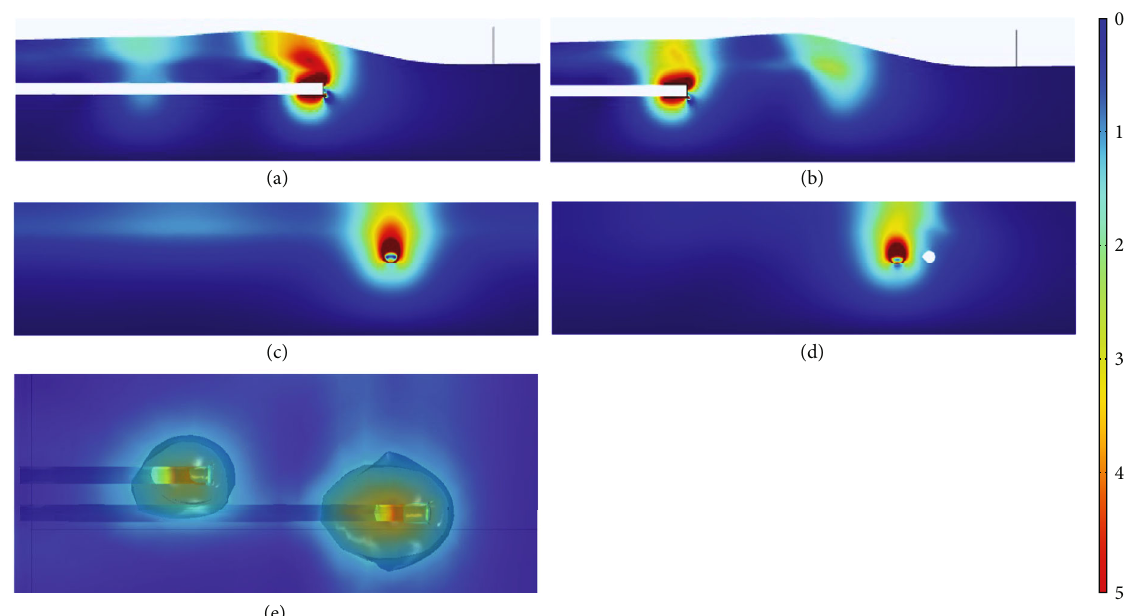
Figure 10: Displacement diagram of the model calculation results of the right line shield through the fl ood control levee: (a) longitudinal section of the right line tunnel; (b) longitudinal section of the left line tunnel; (c) cross-section of the right line tunnel palm face; (d) cross- section of the left line tunnel palm face; (e) top view of the tunnel model displacement.